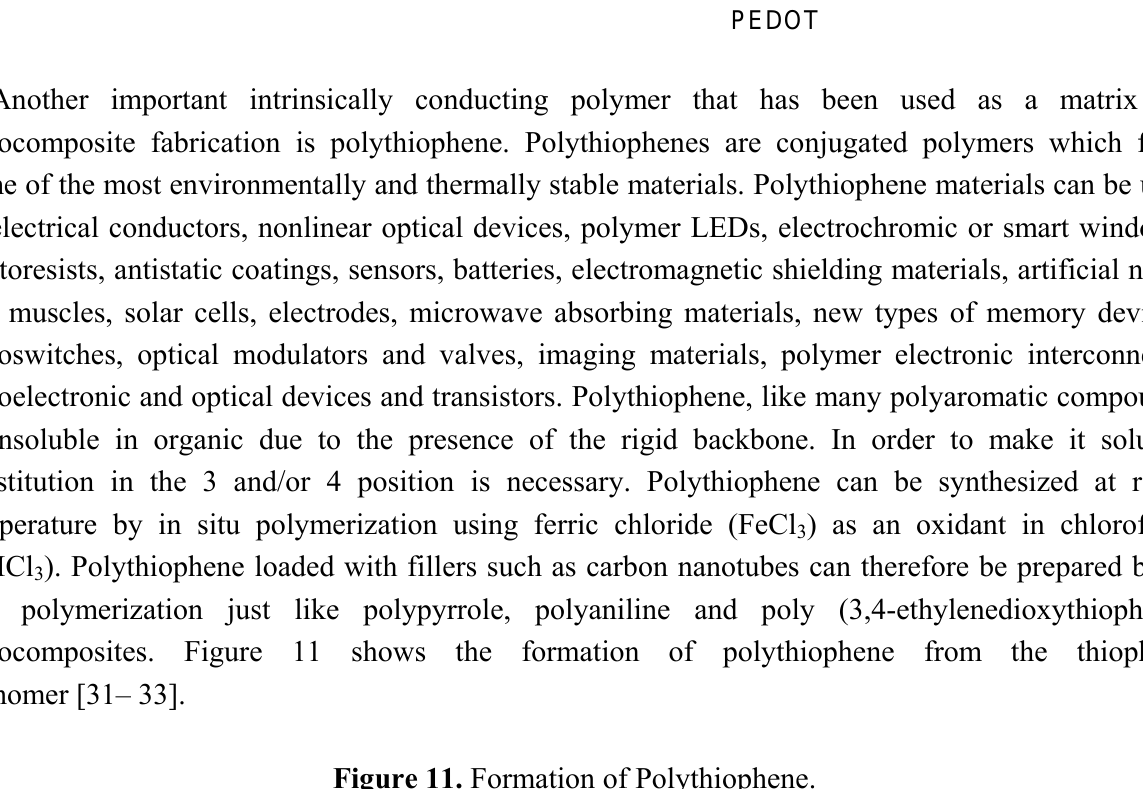
Figure 11. Formation of